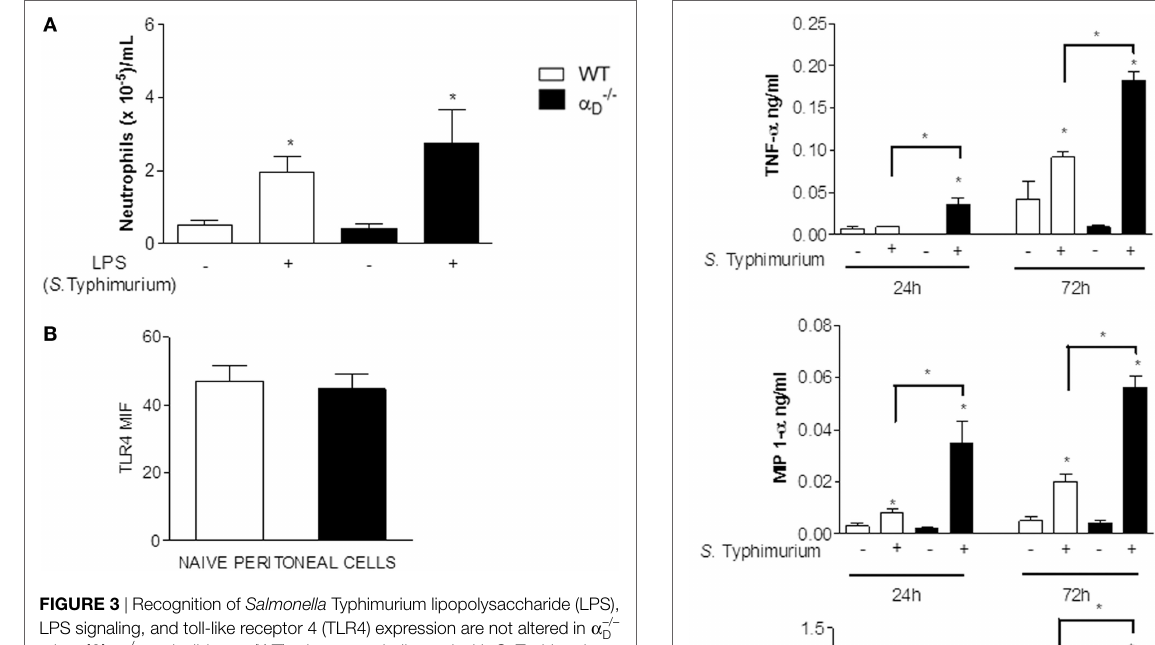
( Figure 5A ). In addition, we found that peritoneal macrophages from α –/– mice released increased levels of IL-1 β , TNF α , and D MIP-1 α compared with WT macrophages when challenged with S. Typhimurium in vitro ( Figure 5C ). This pattern was again similar to that in animals challenged with the bacterium in vivo ( Figure 4 ) and indicates that peritoneal macrophages are a poten- tial source of elevated cytokine levels in the peritoneal exudate in infected α –/– D